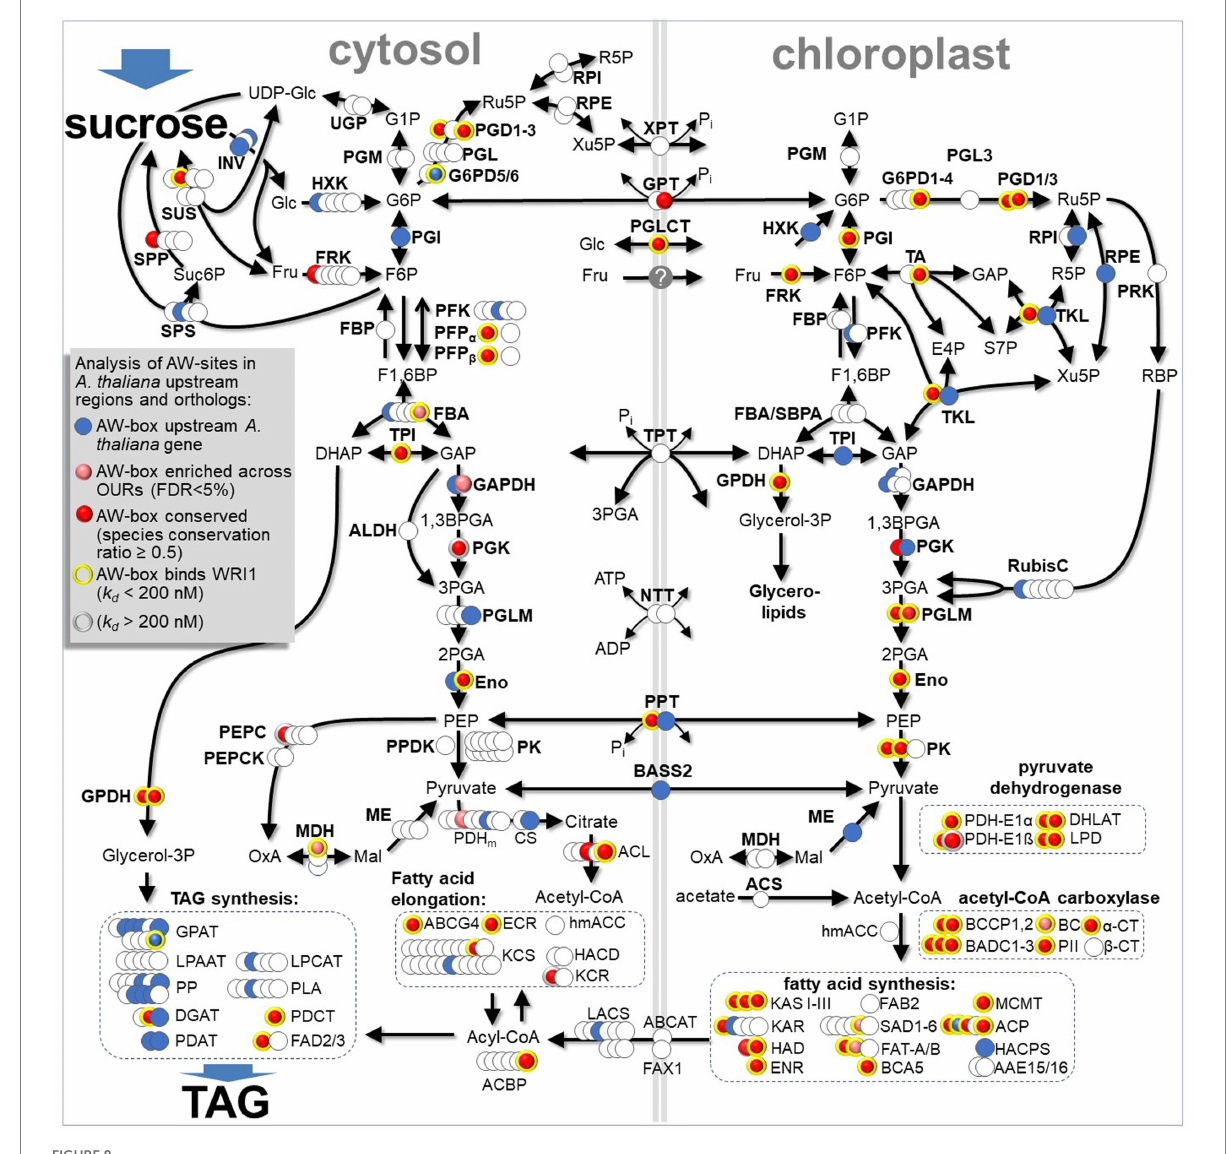
FIGURE 8 Distribution and properties of AW-box sites upstream of genes encoding for conversion of sucrose to TAG in developing seeds of A. thaliana . All reactions and genes are identified in Supplementary Table 3. For all genes with AW-box in the 500 bp upstream region, motif sequences, motif scores, conservation and WRI1 binding affinity are documented in Supplementary Table 9. Reaction abbreviations: AAE15/16, Acyl:acyl carrier protein synthetase; ABCAT, ABC Acyl Transporter; ABCG4, ABC Transporter (cutin, wax); ACBP, acyl-CoA-binding protein; ACL, ATP:citrate lyase; ACP, Acyl Carrier Protein; ACS, acetyl-CoA synthetase; α / β -CT, acetyl-CoA carboxylase carboxyltransferase alpha/beta subunit; ALDH, non- phosphorylating Glyceraldehyde 3-phosphate dehydrogenase; BADC, biotin/lipoyl attachment domain containing; BASS2, Sodium Bile